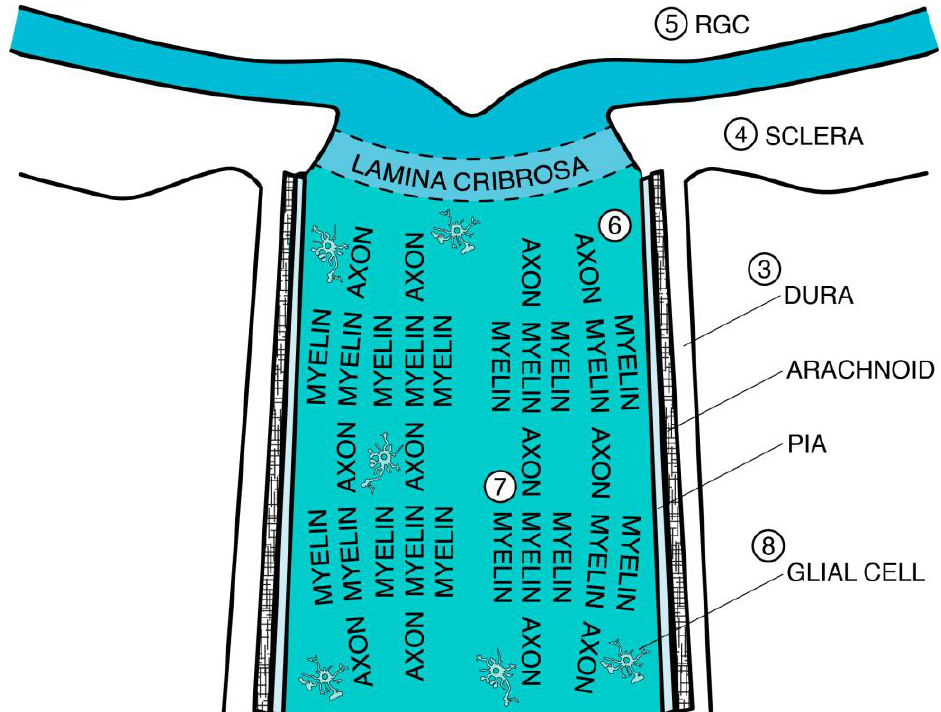
Figure 1. Schematic anatomical image of the optic nerve pertaining to age-dependent neurodegeneration. Numbers correspond with section headings of the present review, specifically “3. Connective Tissue,” which includes “3.4. Dura Mater,” “3.5. Arachnoid and Subarachnoid Space,” “3.6. Pia Mater